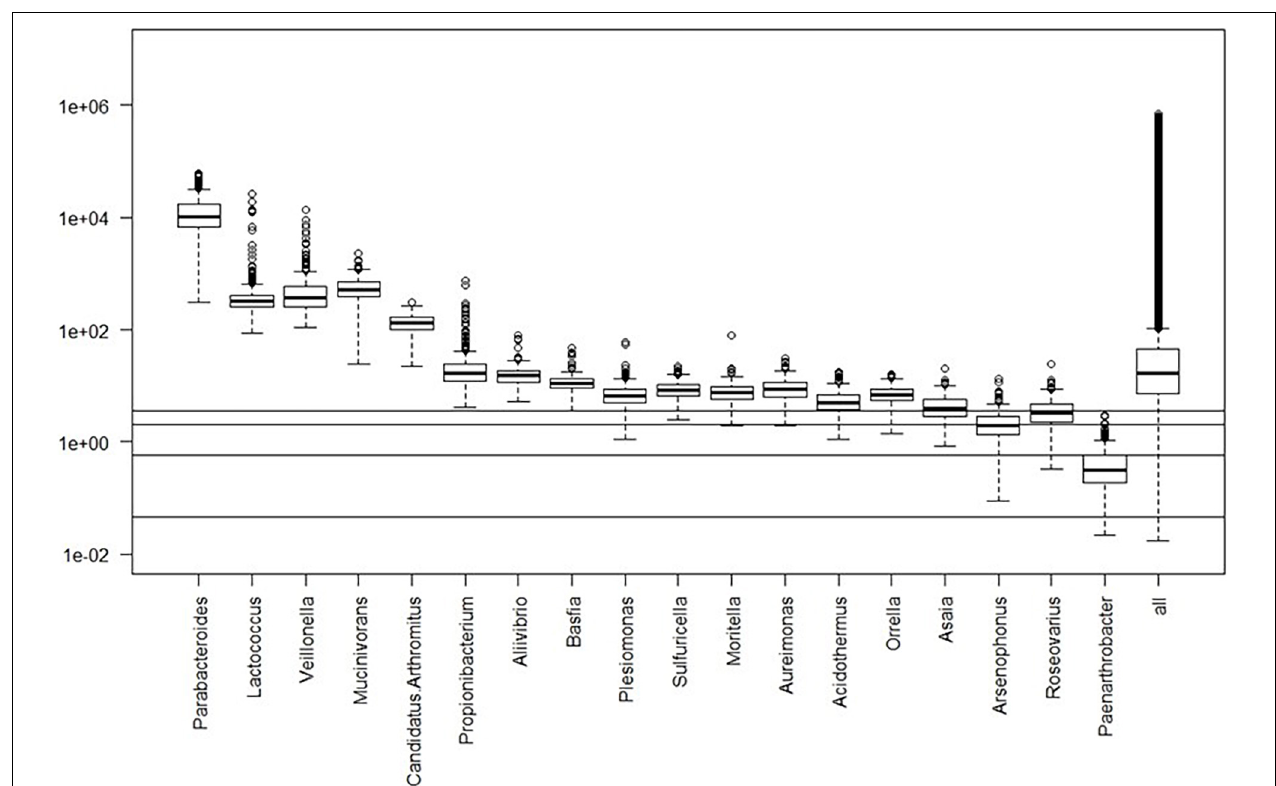
FIGURE 3 | Box plots of the absolute abundances of the 18 genera used in the genera model compared to all genera in our study cohort. The 0.1, 1.0, 5.0, and 10.0% quantiles are given as horizontal lines starting from below.